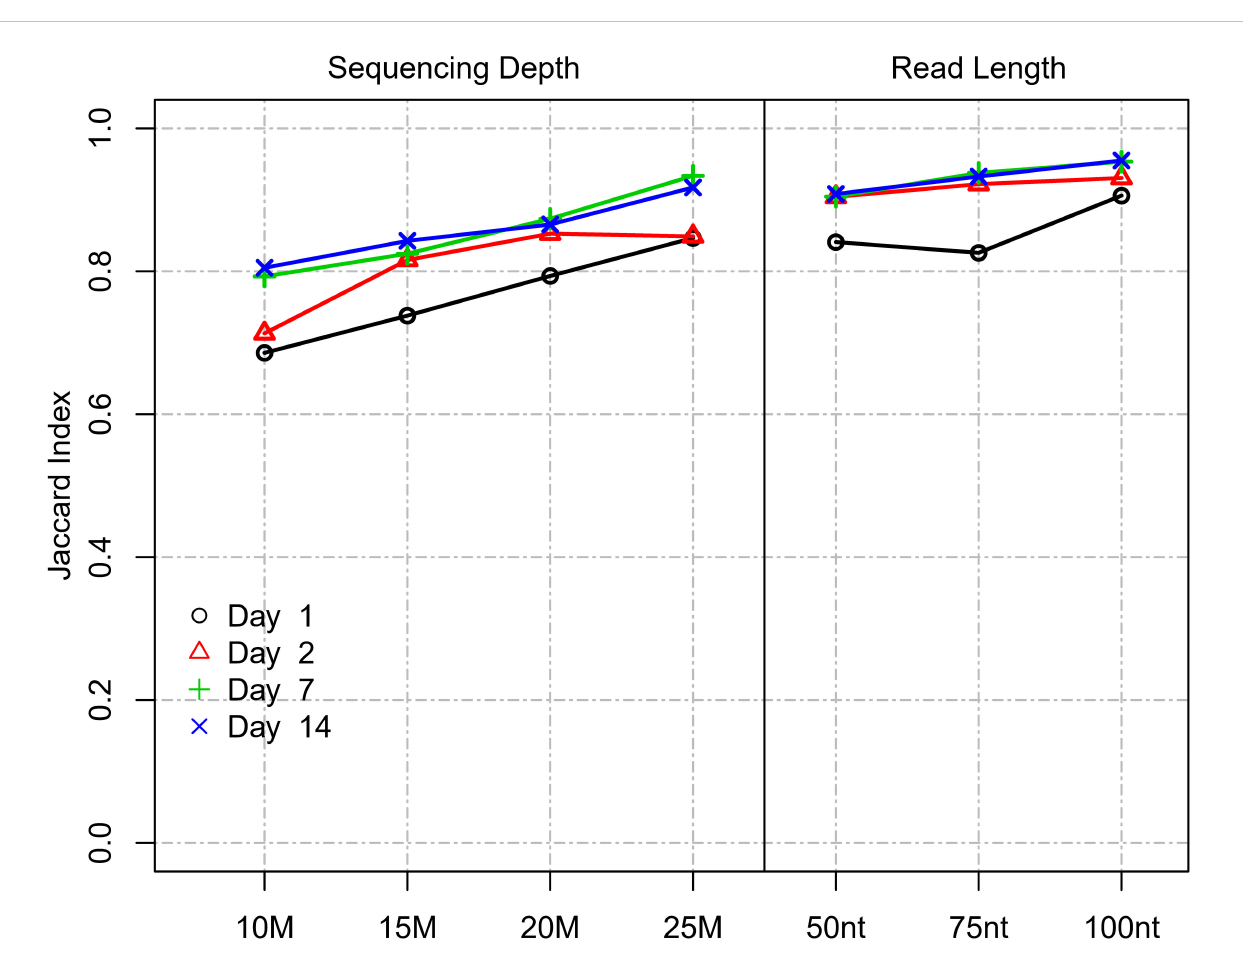
FIGURE 5 Impact of read length and sequencing depth on DEG detection. Impact of read length and sequencing depth on Jaccard index between DEGs (Site 1). The Jaccard index represents the proportion of intersecting DEGs compared to the union of DEGs identi fi ed for a subsampled/truncated dataset and the original